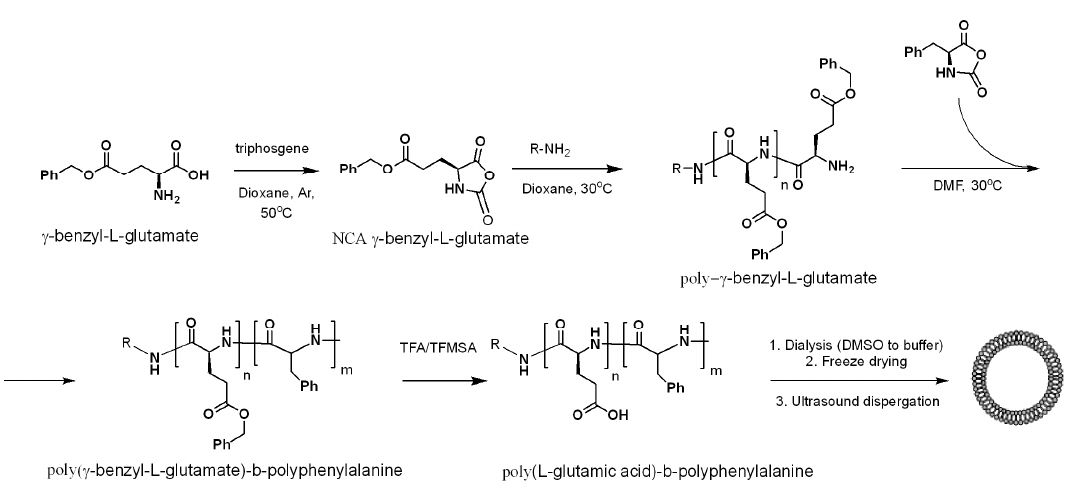
Figure 1. Scheme of synthesis of amphiphilic PGlu- b -PPhe copolymers for preparation of polymersomes.